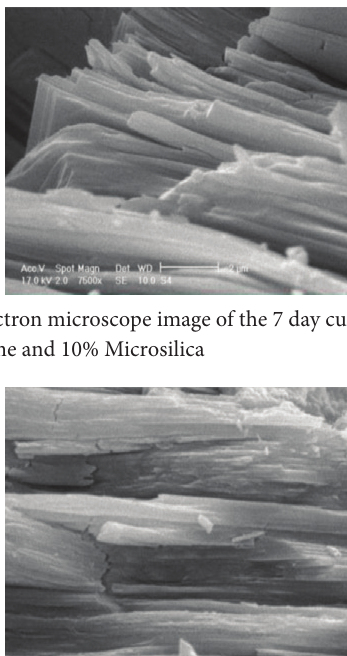
Fig. 15. Electron microscope image of the 28 day curing samples with 5% Lime and 1 % Microsilica